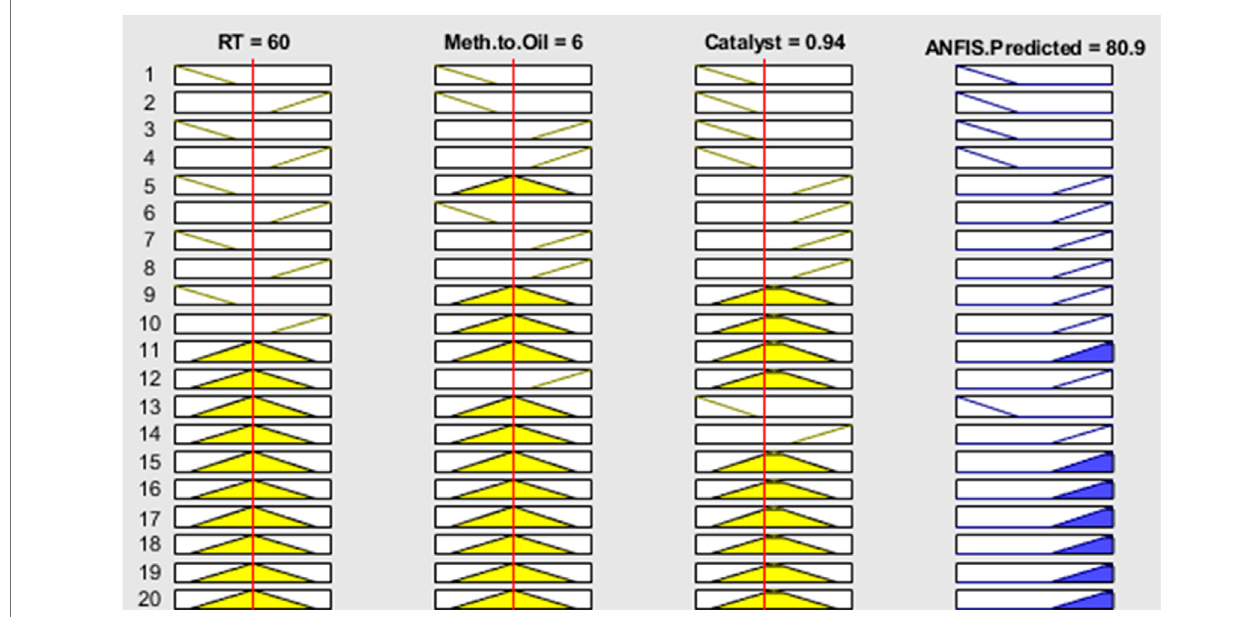
FIGURE 7 | Fuzzy logic rule